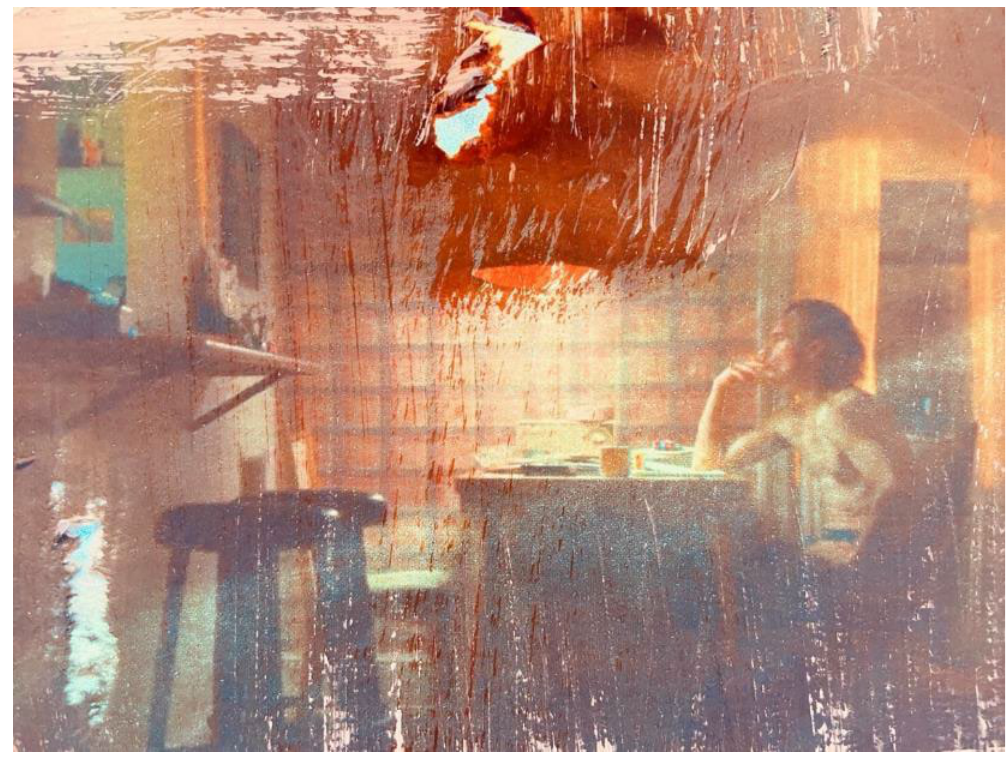
Figure 55 Journal Collage 3